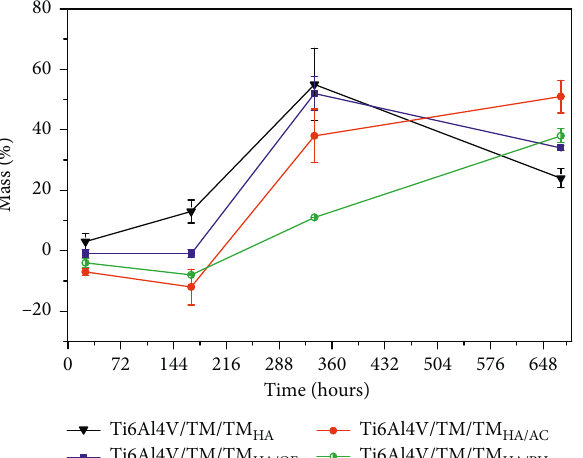
Figure 7: Variation of mass as a function of the time of the nonsterilized and the sterilized (by three different processes) coatings immersed for 24, 168, 336, and 672hours in SBF at 37 ± 3 °